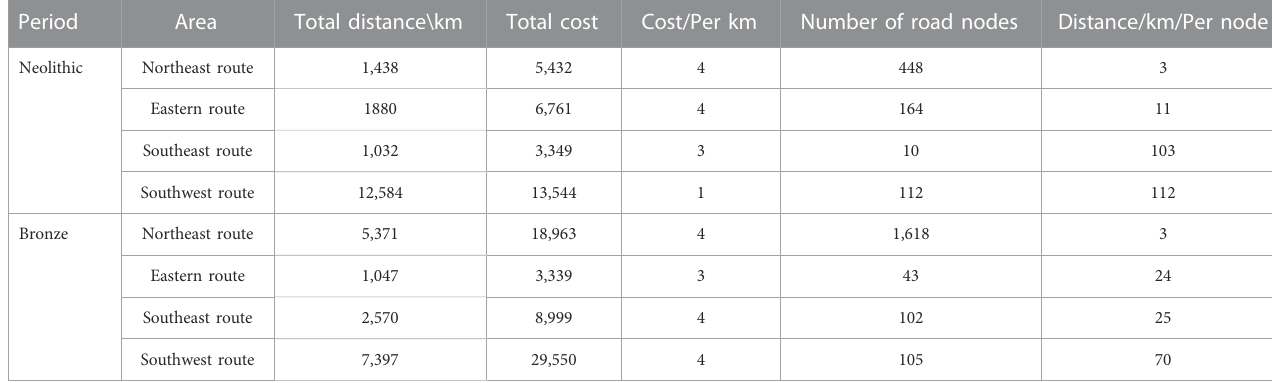
TABLE 1 Comparison of route distance and cost in the Neolithic to Bronze Age, from our exchange route simulation. Period Area Total distance\km Total cost Cost/Per km Number of road nodes Distance/km/Per node